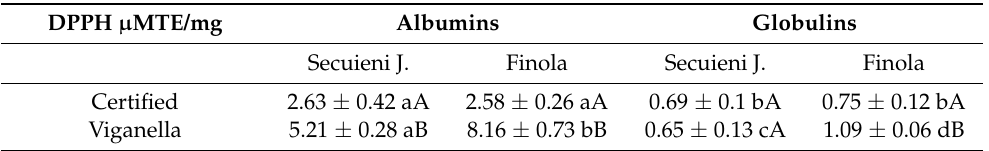
Table 3. Antioxidant properties of albumin and globulin hempseed extracts determined by DPPH assay and expressed as µ MTE/mg